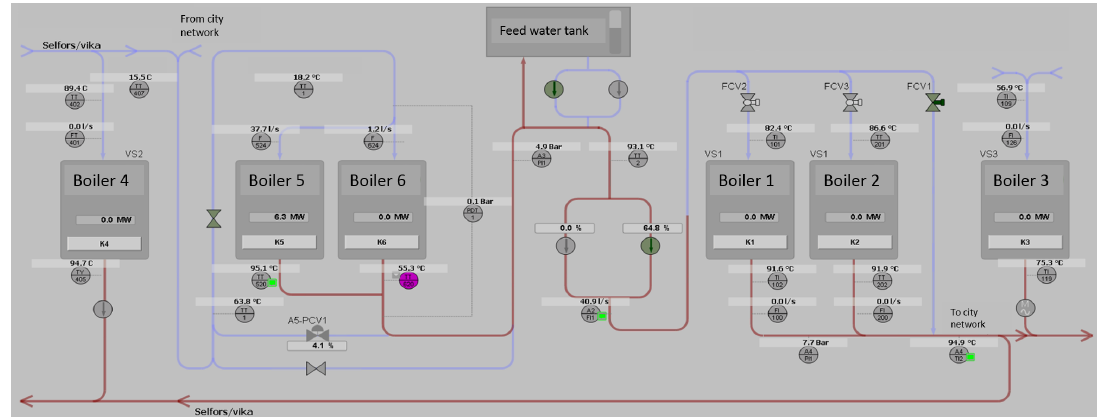
Figure 1. The DH supply system at Mo Industrial Park.